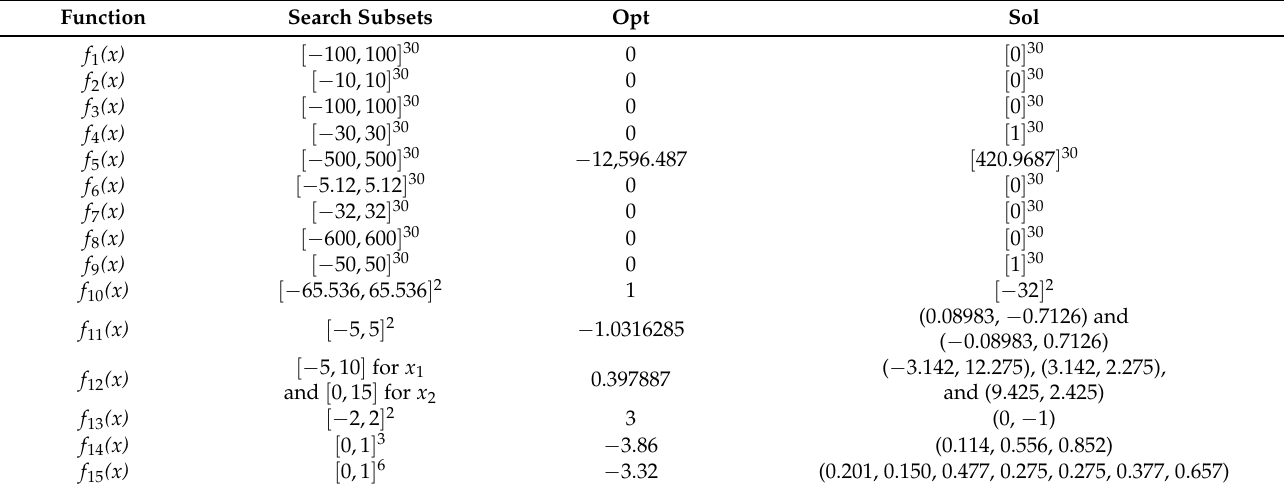
Table 3. Optimum values reported for the benchmark functions in the literature, with their corresponding solutions and search